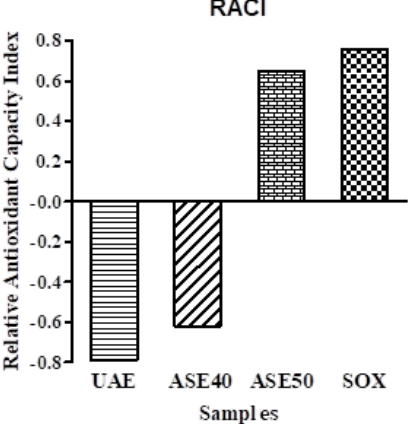
Figure 3. Relative Antioxidant Capacity Index (RACI) values obtained comparing TPC, DPPH, ORAC and BCB results of Aglianico leaf extracts. Samples are extracts obtained by Soxhlet extractive technique (SOX), Accelerated Solvent Extraction at 50 ° C (ASE 50) and Ultrasound Assisted Extraction (UAE).